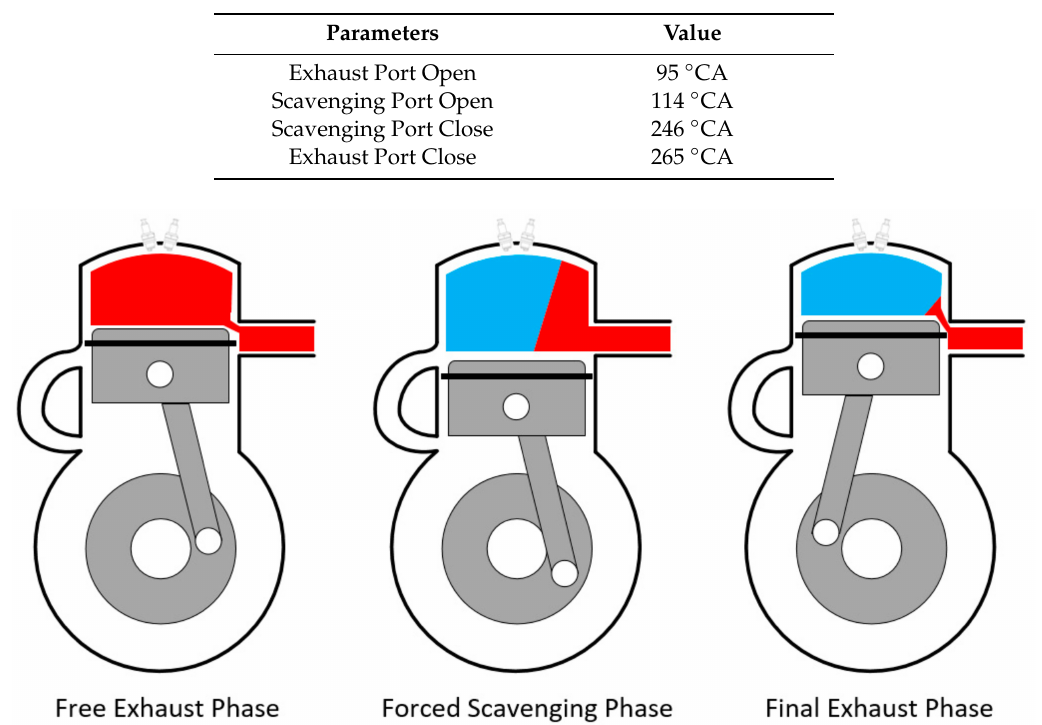
Figure 4. Schematic diagram of the gas exchange process of the initial prototype